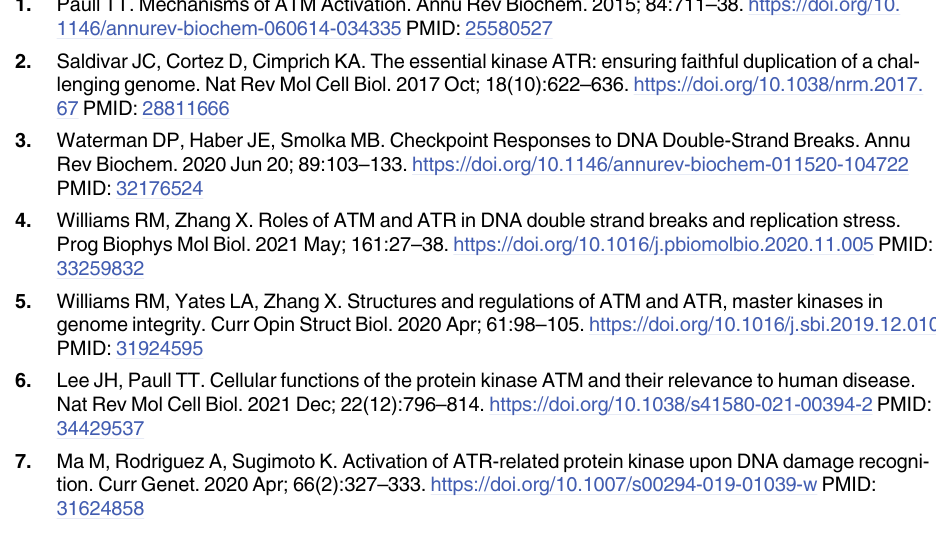
S1 Fig. Complete blots for Figs 2C and 6C. S2 Fig. Replicate experiment for the one shown in Fig 3C. S3 Fig. Uncropped gel